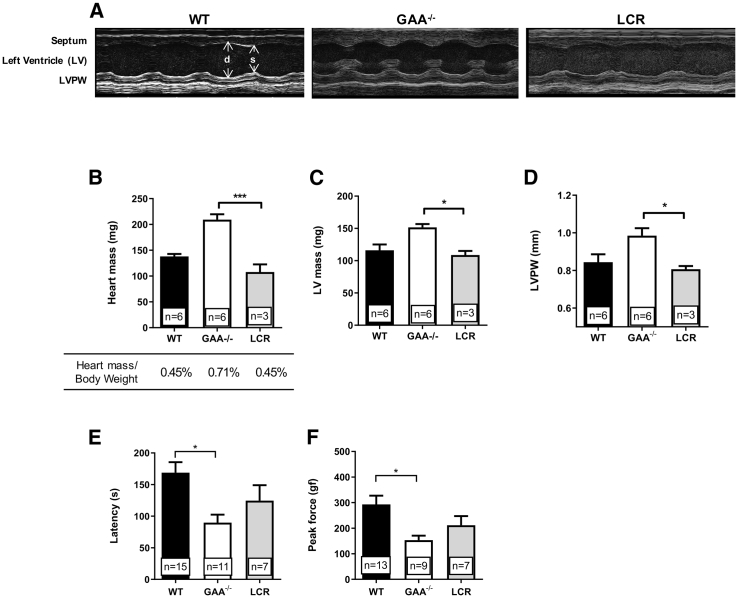
Assessment of Cardiac and Motor Functions in GAA−/− Mice Treated with LV.LCR-EFS.GAA HSC Gene Therapy(A) Representative M-mode images showing septum, left ventricular space, and left ventricular posterior wall (LVPW) of wild-type, GAA−/−, and LV.LCR-EFS.GAA (LCR)-treated mice during diastole (d) and systole (s). (B–D) Heart mass and percentage of heart mass on total body weight (B), left ventricle (LV) mass (C), and thickness (D) of the LVPW of LCR-treated mice compared to wild-type and GAA−/− littermates. (E and F) Motor coordination assessed by rotarod (E) and muscle strength (F) measured by grip strength meter of LCR-treated mice compared to wild-type and GAA−/− littermates. Cardiac performances were evaluated via echocardiography in mice that showed VCN > 0.8 (details in Table S1). Data are shown as means ± SEM of three independent experiments with number of mice (n =) indicated in the graphs.